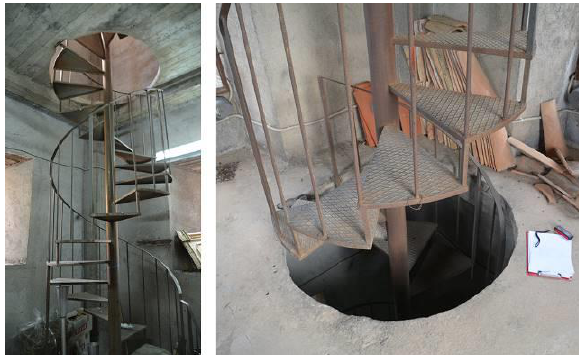
Figure 13. The steel spiral staircase in the bell tower of SS. Trinità in Bronte (Ct).